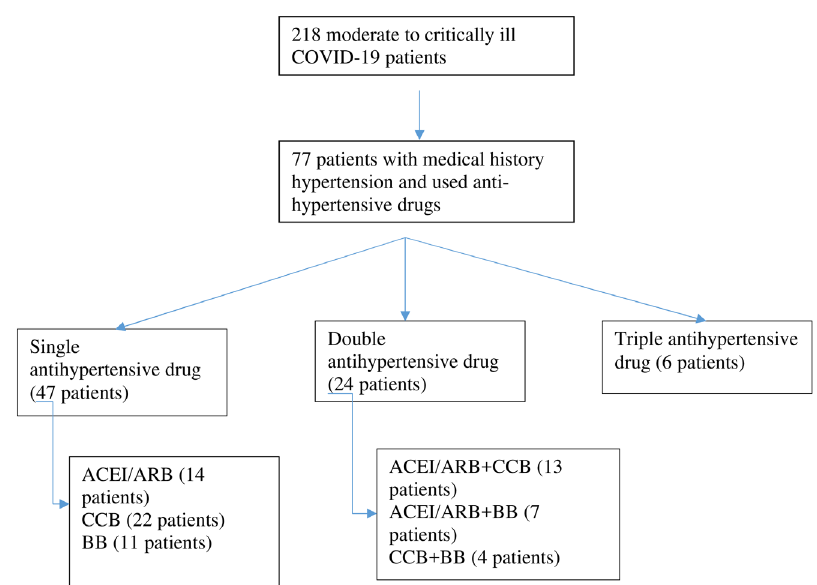
Figure 1. Selection of patients. ACEI/ARB: angiotensin-converting enzyme inhibitors and angiotensin receptor blockers; CCB: calcium channel blocker; BB: beta blocker.